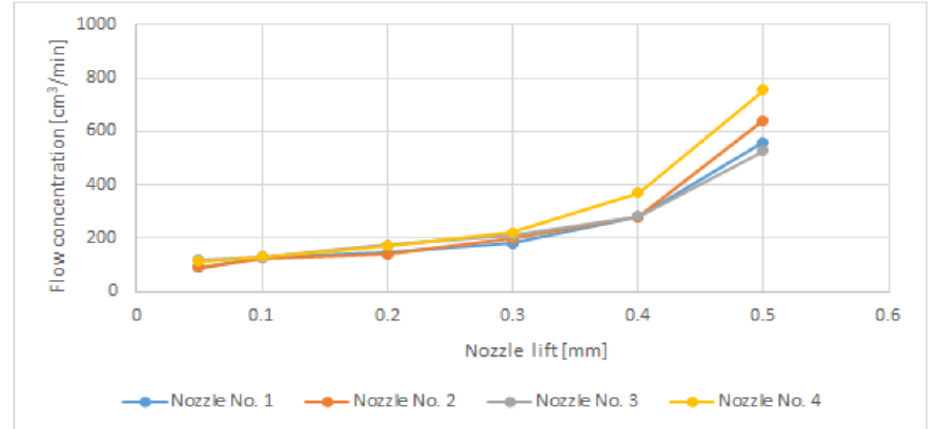
Figure 3. The flow after the test for diesel fuel.